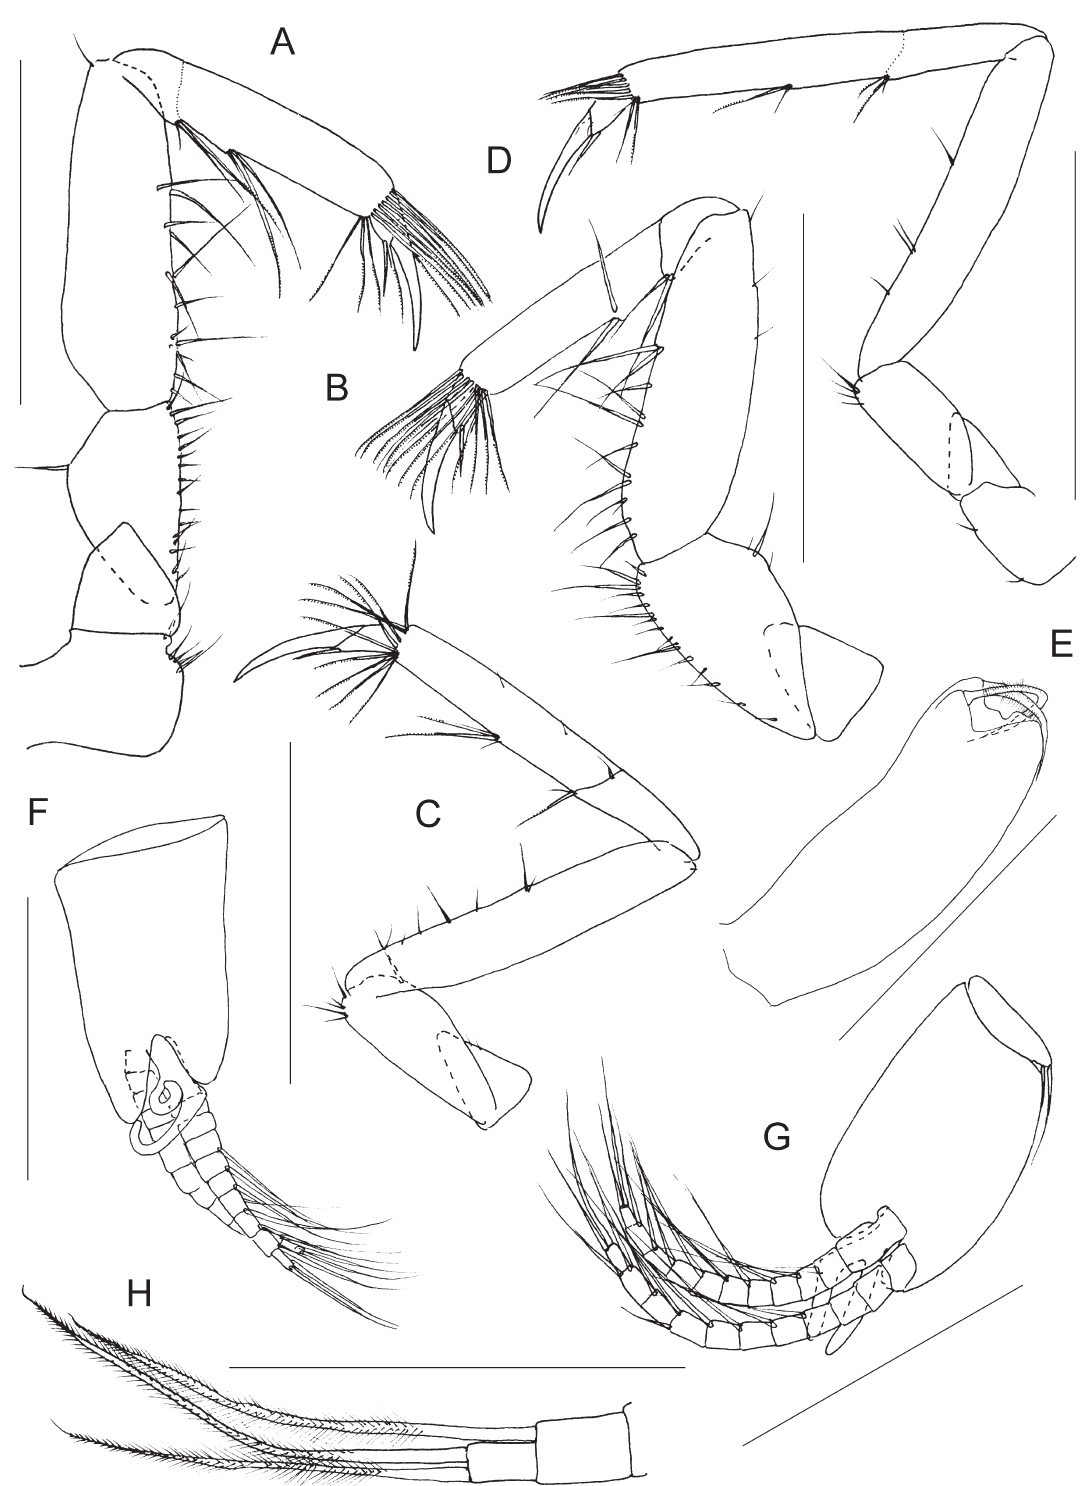
Fig. 10. Siriella brevicaudata Paulson, 1875, ♂, length 4.5 mm, Arabian Gulf, Bahrain. A . Endopod of pereopod 1, anterior view. B . Endopod of pereopod 2, posterior view. C . Endopod of pereopod 5, posterior view. D . Endopod of pereopod 6, posterior view. E . Penis. F . Pleopod 2, posterior view. G . Pleopod 5, anterior view. H . Distal setae of pleopod 4. Scale bars: A–D, F–G = 0.5 mm; E, H = 0.25